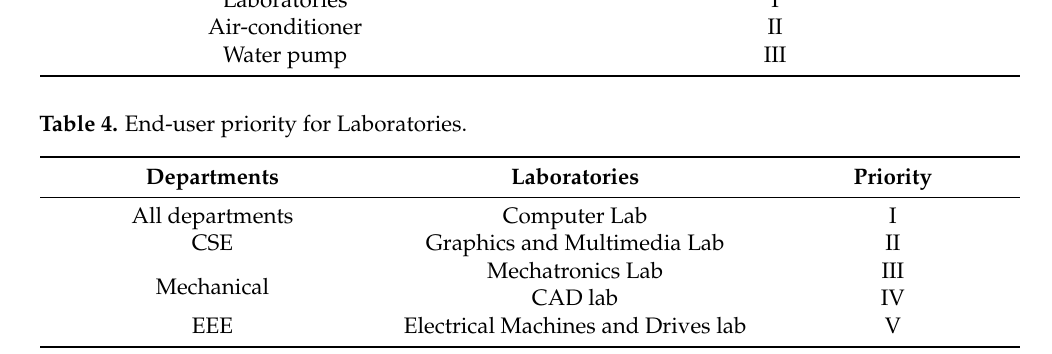
Table 5. Twenty-five kilowatt load—peak clipped in the afternoon session.